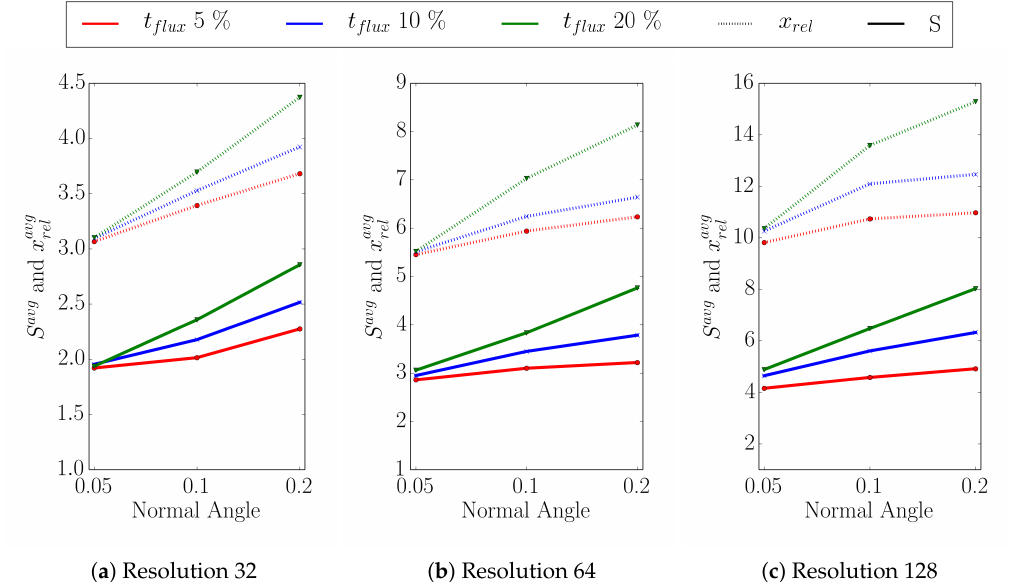
Figure 10. Average speedups S avg (solid lines) and average ratios x avg flux (red, blue, green) and three different normal angle thresholds (x-axis) for level-set resolutions of ( a ) 32, ( b ) 64, and ( c )